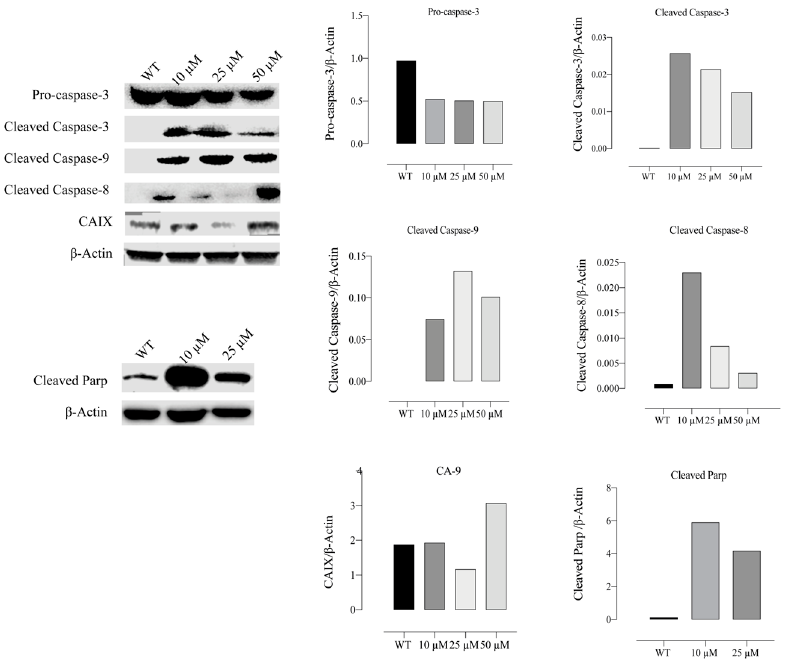
Figure 10. Measurement of apoptotic proteins, caspases 3, 8, and 9. HeLa cells were treated with compound E at different doses of 0, 10, 25 and 50 µ M. Protein levels of apoptosis were normalized to β -actin. The compound E dramatically increased the cleavage levels of caspase 3, 8, and 9 proteins in a dose-dependent manner. The cleavage PARP protein level also increased with the treatment of compound E at a dose of 10 µ M. The most effective dose of compound E on CAIX was found to be 25 µ M. The densitometry quantification of the blot was determined by software (Li-Cor Fc). The data are presented as the mean ± SD (n = 3).